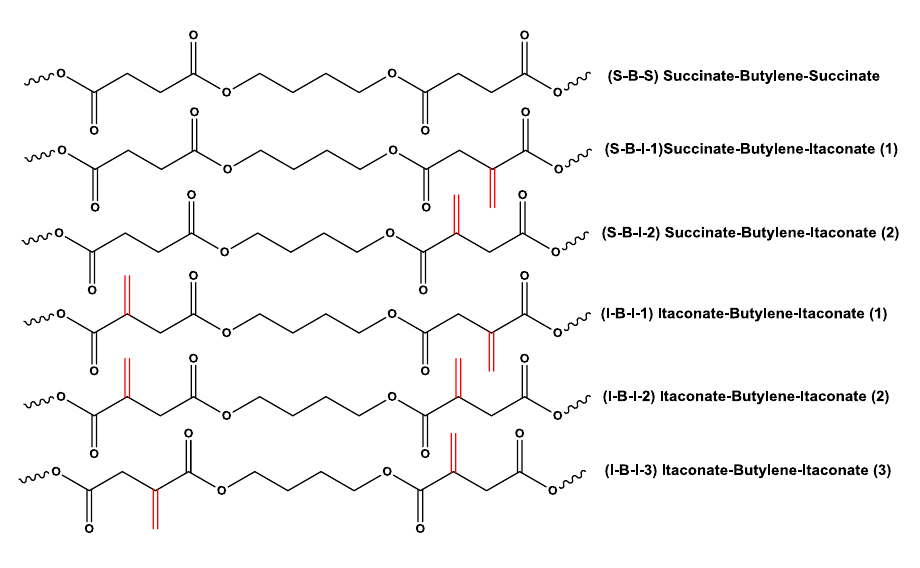
Figure 7. Possible types of microstructures in PBSI, the formation sequence from easy